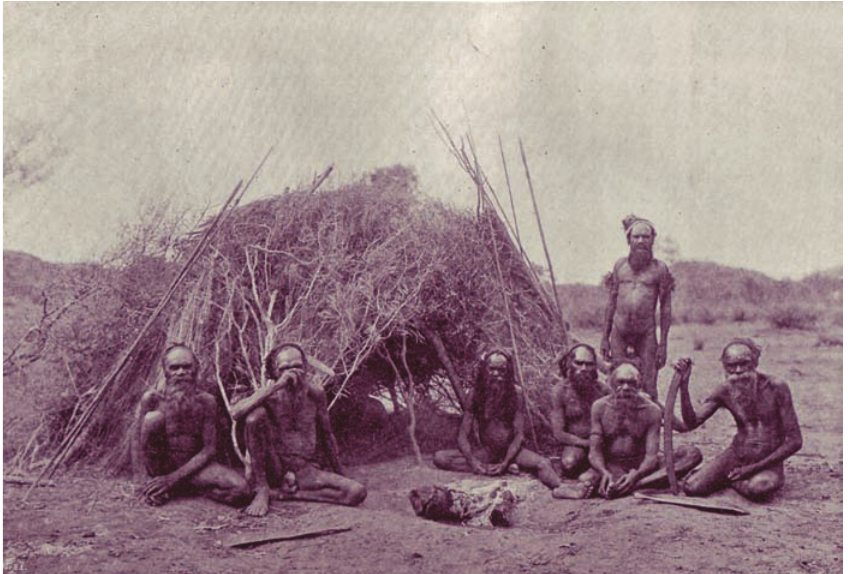
Figure 1 A group of Central Australian